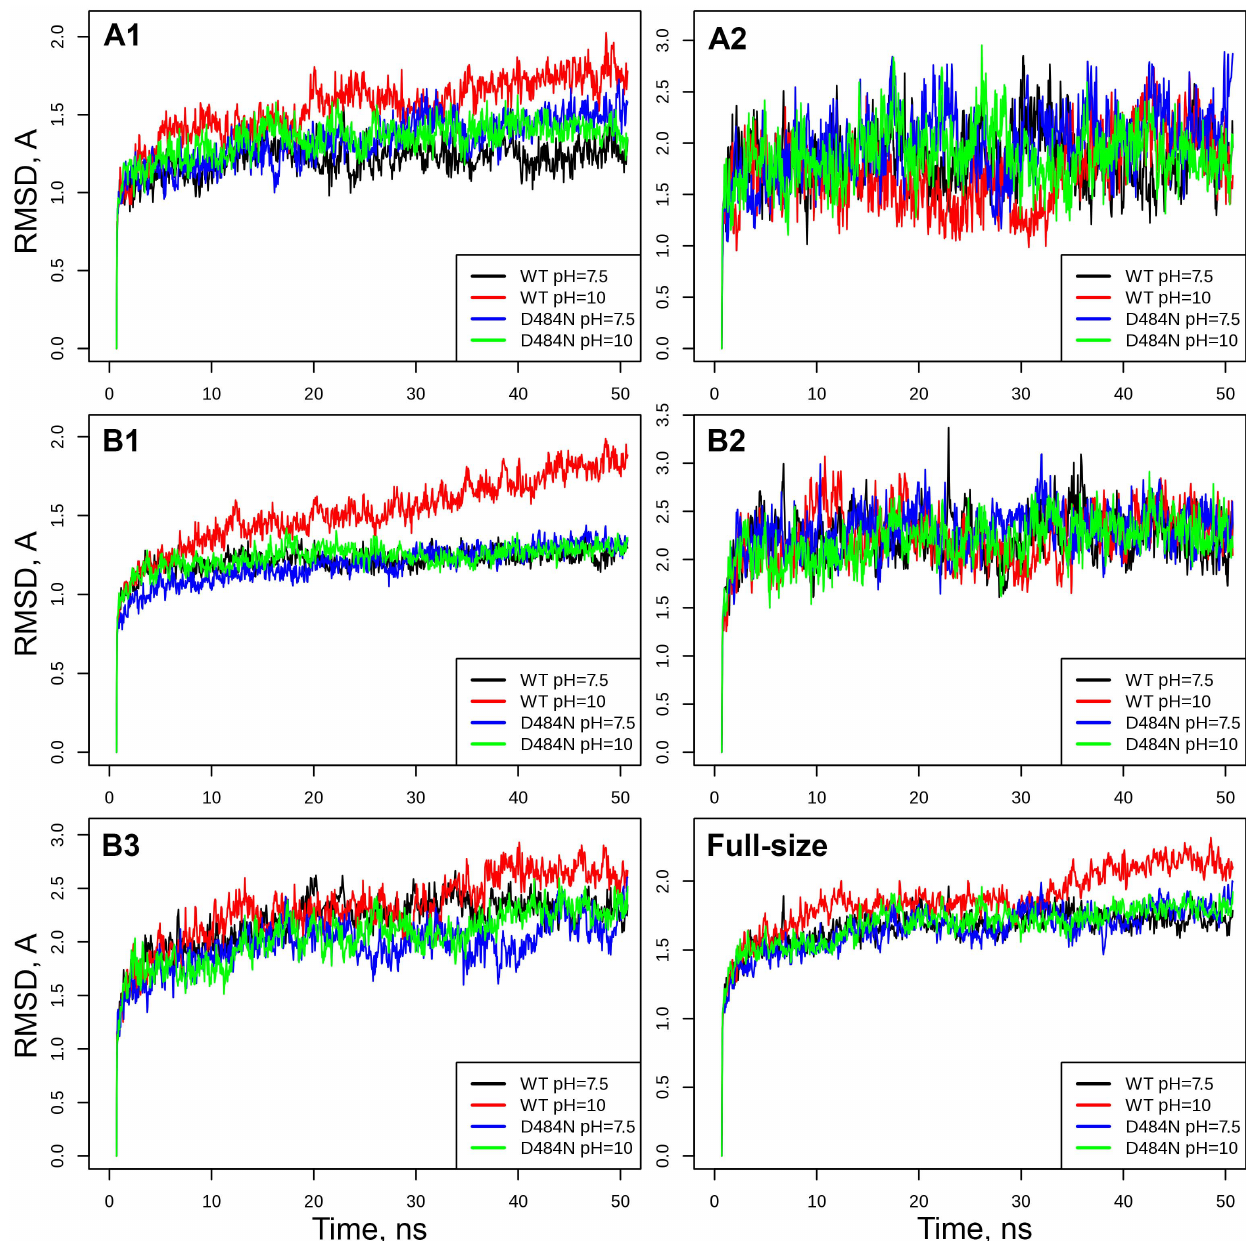
Figure 1. Root mean square deviation (RMSD) of different structural domains during 50 ns MD simulations. Results are shown for Ec PA and its D b 484N mutant at different pH. Each curve is averaged over three independent MD